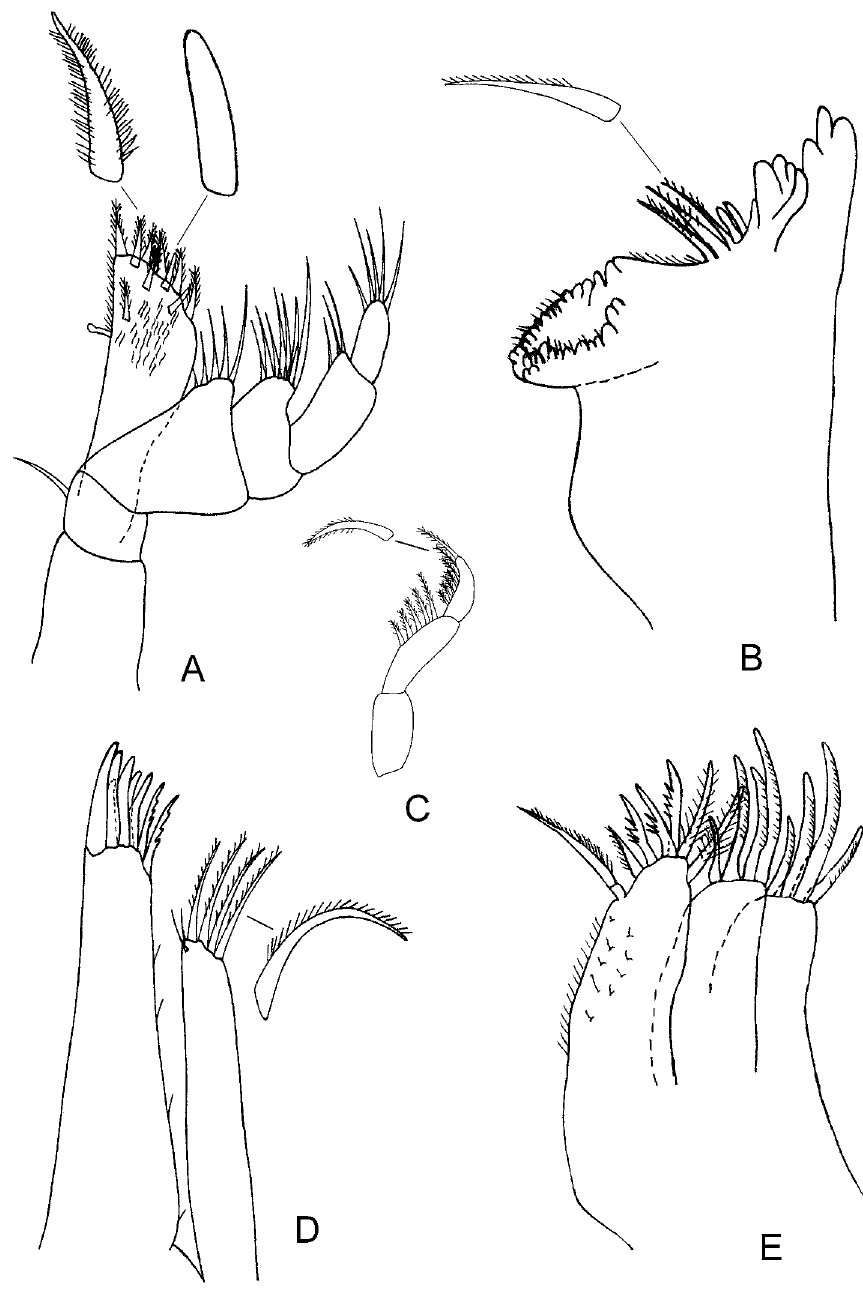
Figure 4. Sphaeromopsis jayaraji sp. nov., holotype male (2.9 mm) (PUMB 35104). A , maxilliped; B , mandible; C , mandible palp; D , maxillula; E ,